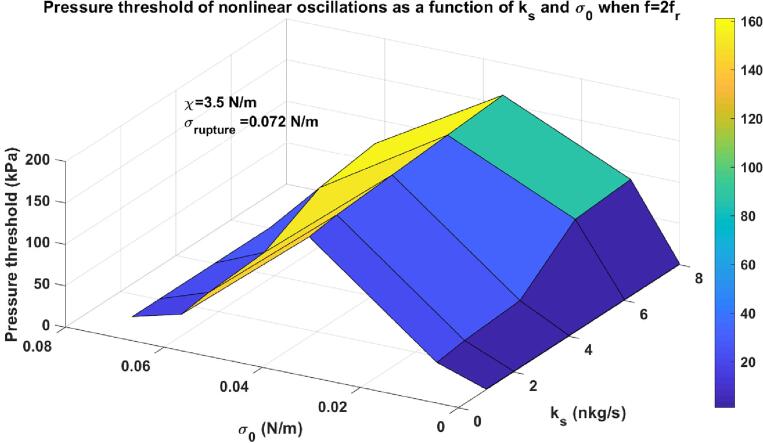
Pressure threshold for the onset of nonlinear oscillations (P2 or P3) as a function of ks and σ0 when f=2fr for a C3F8 lipid coated bubble with χ=3.5N/m and σrupture=0.072 N/m. The colors and the z-axis represent the pressure threshold for the onset of nonlinearity.